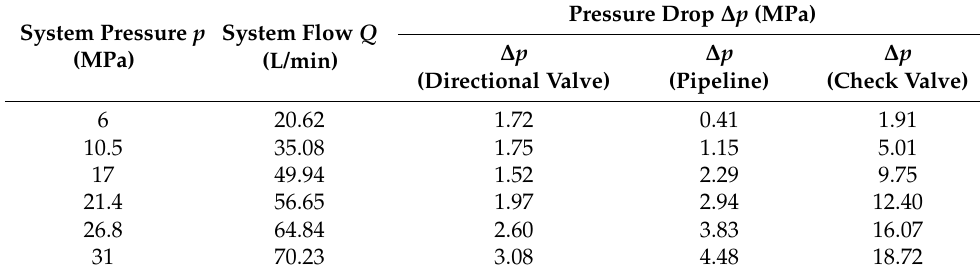
Table 4. Hydraulic cylinder extension data under DN10 pipeline diameter.